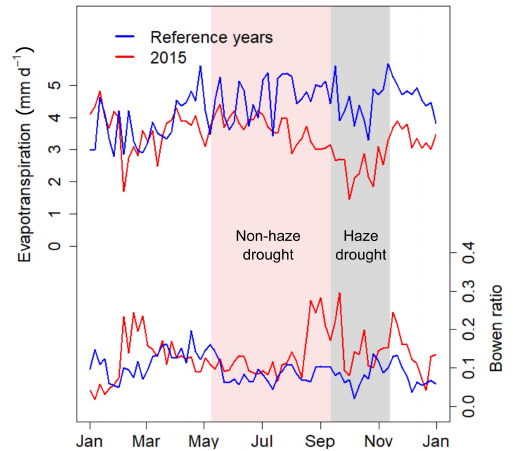
Figure 5. The 5d running mean of daily evapotranspiration and ra- tio of sensible to latent heat fluxes (Bowen ratio) during 2015 and the reference time period. Shaded areas in red and grey mark the non-haze drought and the haze drought period in 2015,